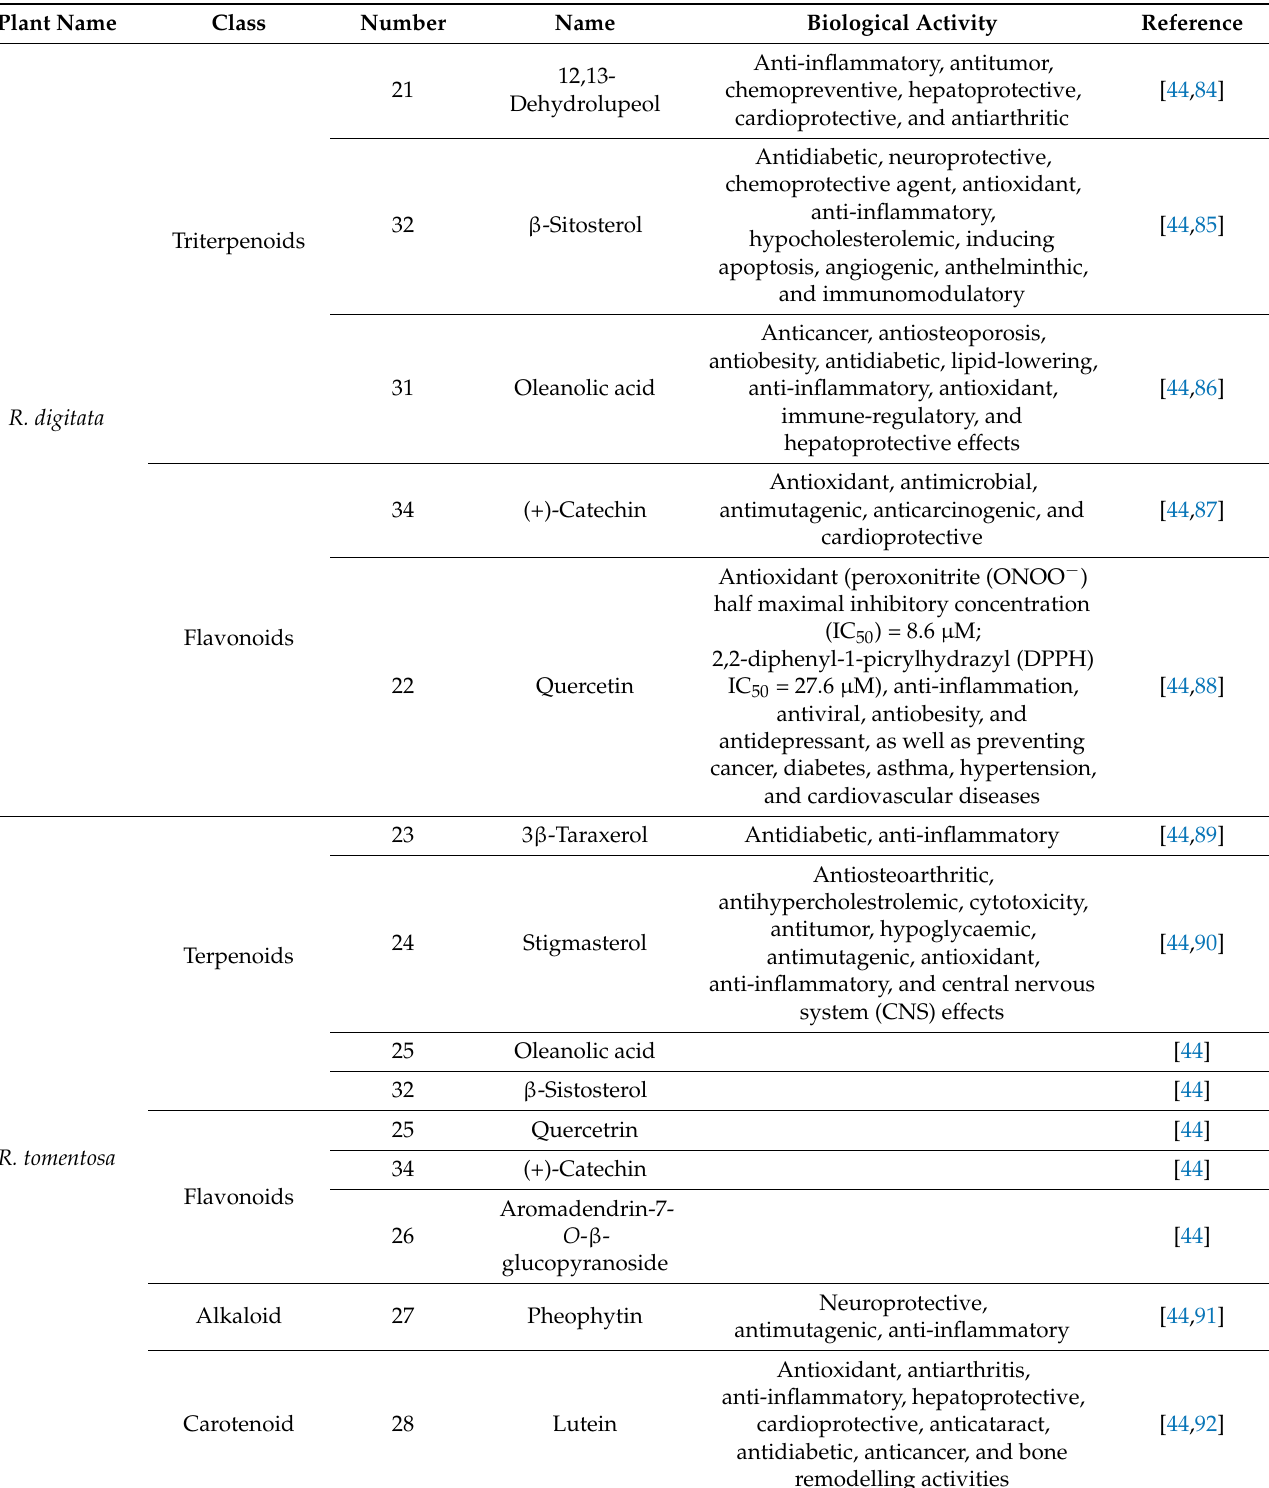
Table 5. Compounds isolated from Rhoicissus